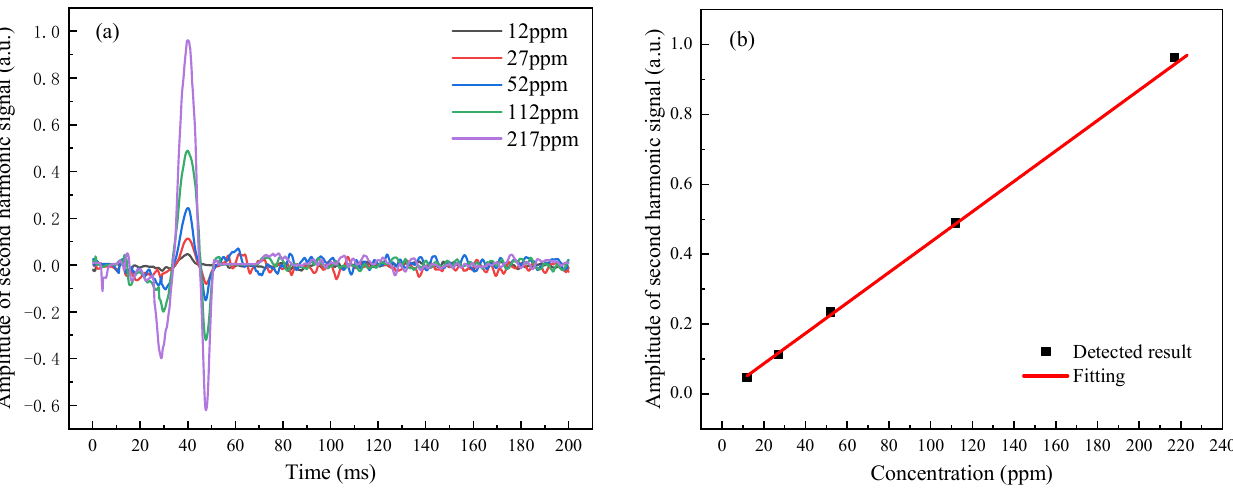
Figure 4. Detected result of CO with different concentrations in the gas chamber based on TDLAS: ( a ) waveforms of the second harmonic signal; and ( b ) amplitudes of the second harmonic signal. The scanning period of the laser modulation signal was 200 ms. By continually collecting the detection signal for 50 times, it was possible to achieve the stability of the gas detection result within 10 s. Figure 5 displayed the stability of the ASH for gases at various concentrations. The relative standard deviations of CO detection signals with concentrations of 12 ppm, 27 ppm, 52 ppm, 112 ppm, and 217 ppm were 0.019, 0.029, 0.024, 0.02, and 0.017, respectively. The measurement results of the CO detection system based on TDLAS were stable because the low-frequency background noise could be suppressed. detect CO gas in the